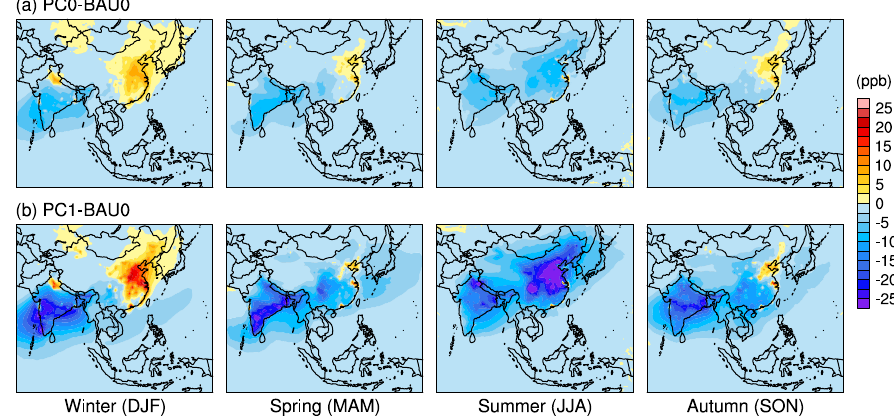
Figure 12. Horizontal distributions of differences in simulated seasonal mean surface ozone concentrations between (a) PC0 and BAU0, and (b) PC1 and